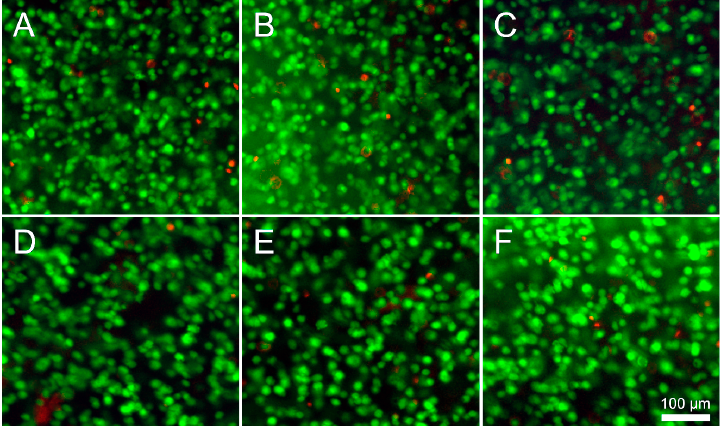
Figure 7. Viability of human articular chondrocyte cells during 7 day culture. ( A – C ) day 1 and ( D – F ) day 7, conducted on ( A,D ) GelMA, ( B,E ) GelMA/0.25% GG and ( C,F ) GelMA/0.25% GGMA. FDA stained live cells green whilst PrI stained dead cells red. Initial culture was used to assess cytotoxicity of the NaCl + mannose blend as well as individual cytotoxicity of each hydrogel component.